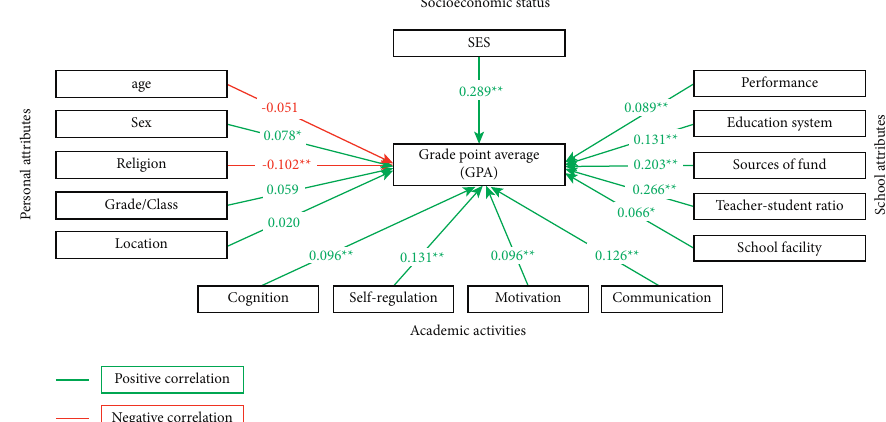
Figure 2: Bivariate correlation between academic achievement and independent variables. GPA: grade point average; SES: socioeconomic status. ∗∗ Correlation is significant at the 0.01 level (2-tailed). ∗ Correlation is significant at the 0.05 level